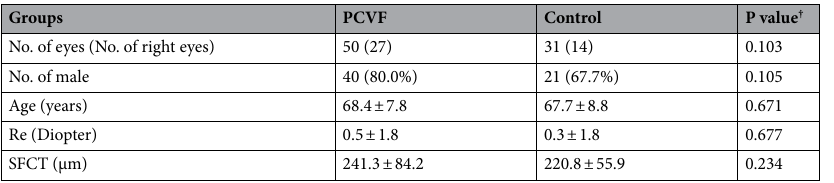
Table 1. Characteristics of participant groups (mean ± SD). Re refractive error, SFCT subfoveal choroidal thickness, PCVF PCV fellow eyes, Control age-matched control group. † Student